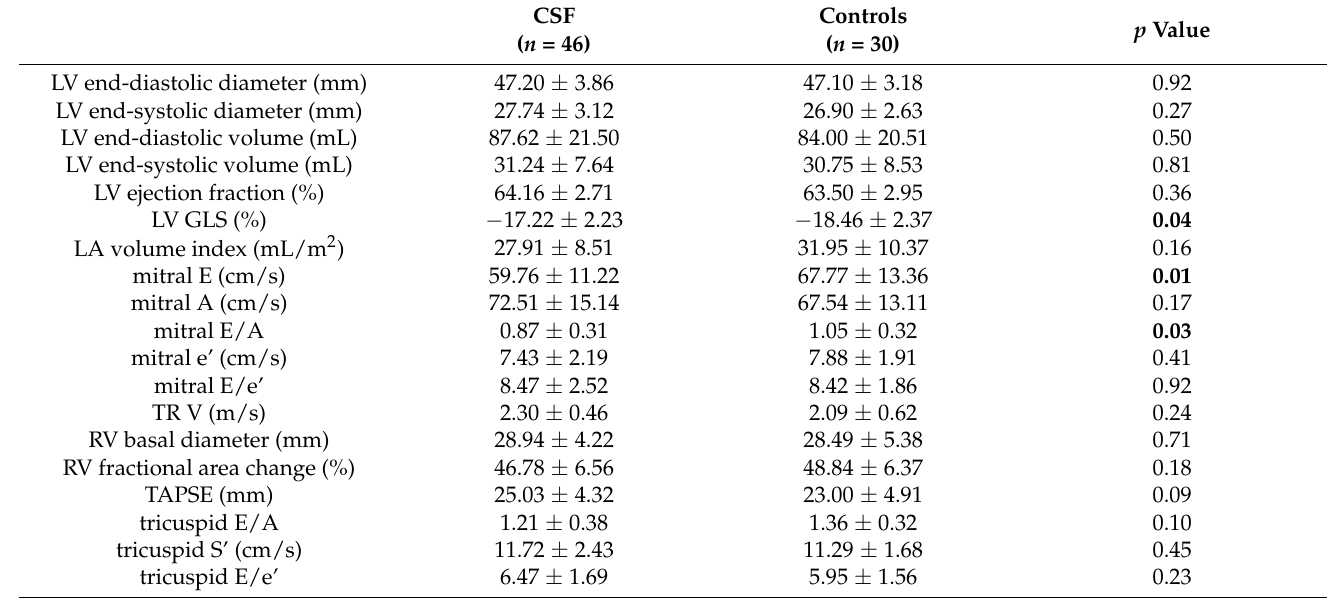
Table 3. Comparison of left and right ventricular